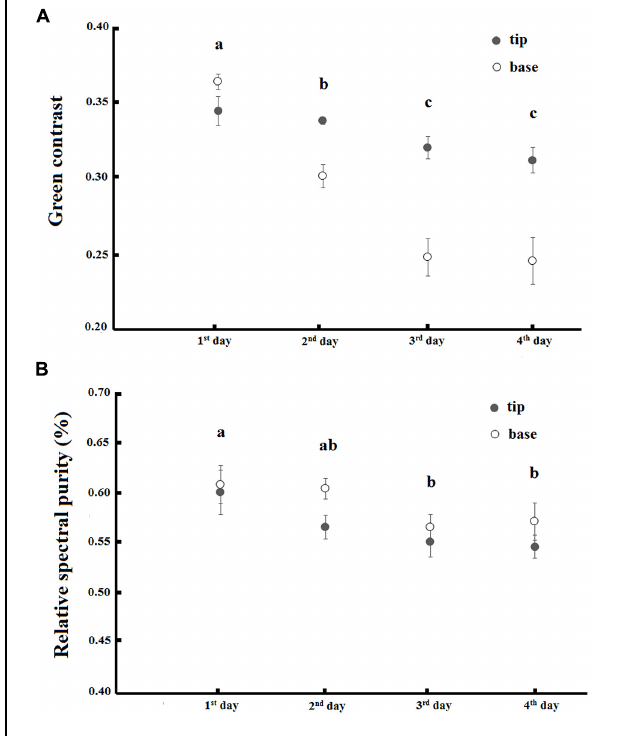
FIGURE 5 | Green contrast (A) and relative spectral purity (B) variation along the 4 days of anthesis in base and tip of petals of T. pulchra flowers. Bars indicate SE. Letters indicate significant differences ( p < 0.05) between the days after pairwise t -test with FRD-controlling